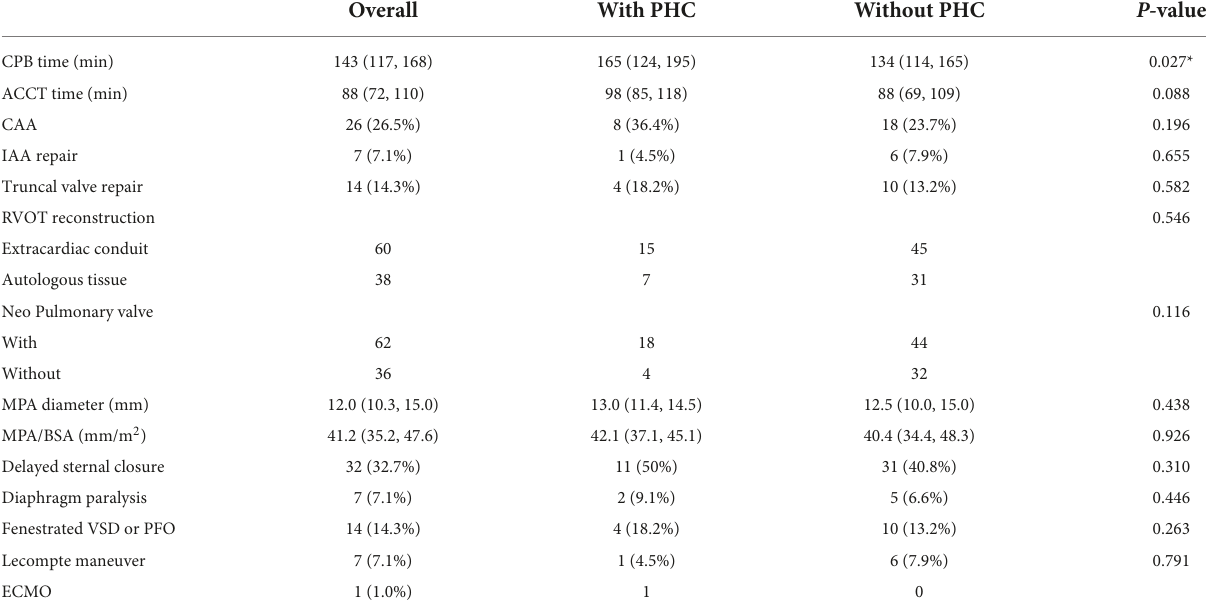
TABLE 2 Operation data.